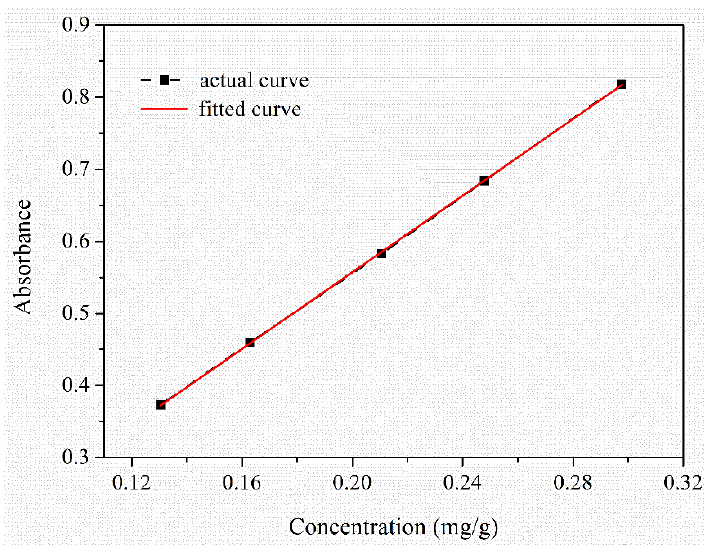
Figure 9. Variation curve of absorbance with the concentration of TO in n-hexane.